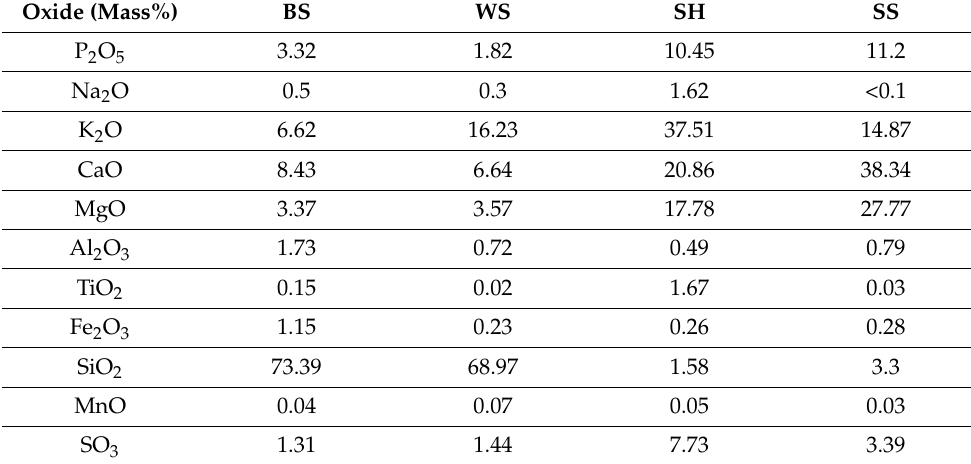
Table 3. Chemical composition of laboratory-generated